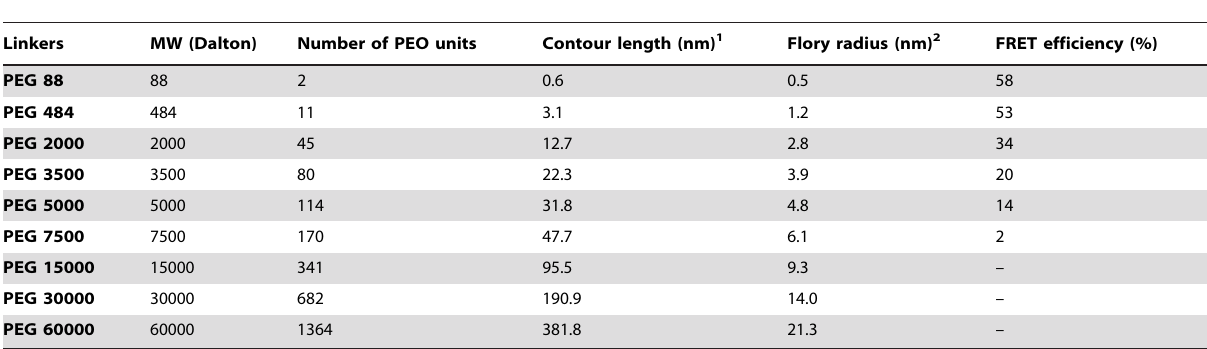
Table 1. PEG linkers and